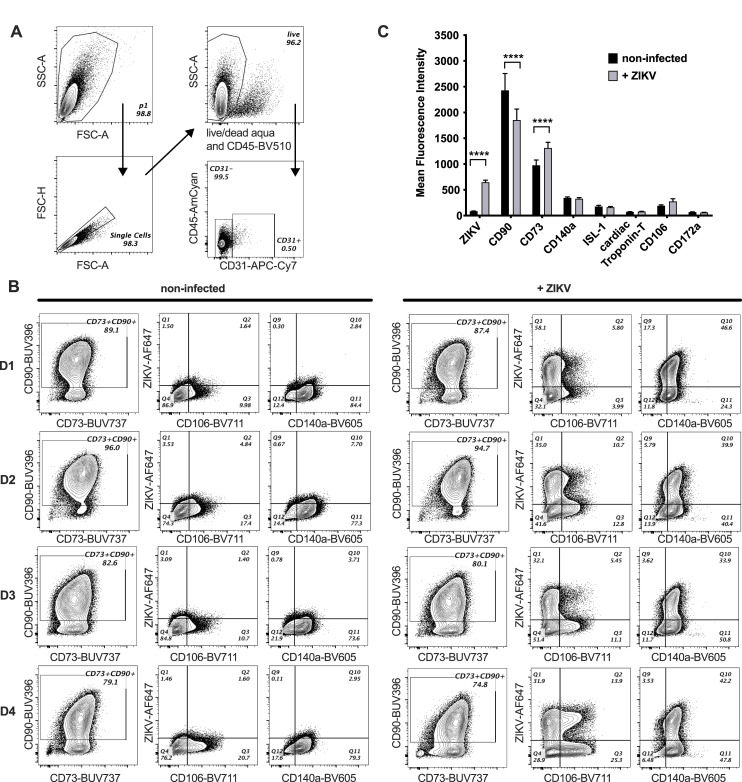
ZIKV infection alters expression of mesenchymal markers.fcMSCs (n = 4) were infected or not with 1 MOI ZIKV for 6 h. Cell surface staining was performed 48 h post-infection using antibodies against CD31, CD45, CD73, CD90, CD106, CD140a and CD172a; and intracellular staining with 4G2 antibody (for ZIKV detection), ISL-1, and cardiac Troponin-T. (A) fcMSCs were selected for their size (FSC vs SSC), viability, and subsequently CD45−CD31− cells were used to assess expression of selected markers. (B) Flow cytometry assessment of indicated markers expression, with and without ZIKV infection. Mean MFI of all markers for all donors tested are plotted with error bars indicating SEM. D1—D4: donors 1–4. (C) Bar graphs depicting mean fluorescence intensity (MFI) for different markers in ZIKV infected cells (grey bars) or non-infected controls (black bars) with ZIKV as indicated.